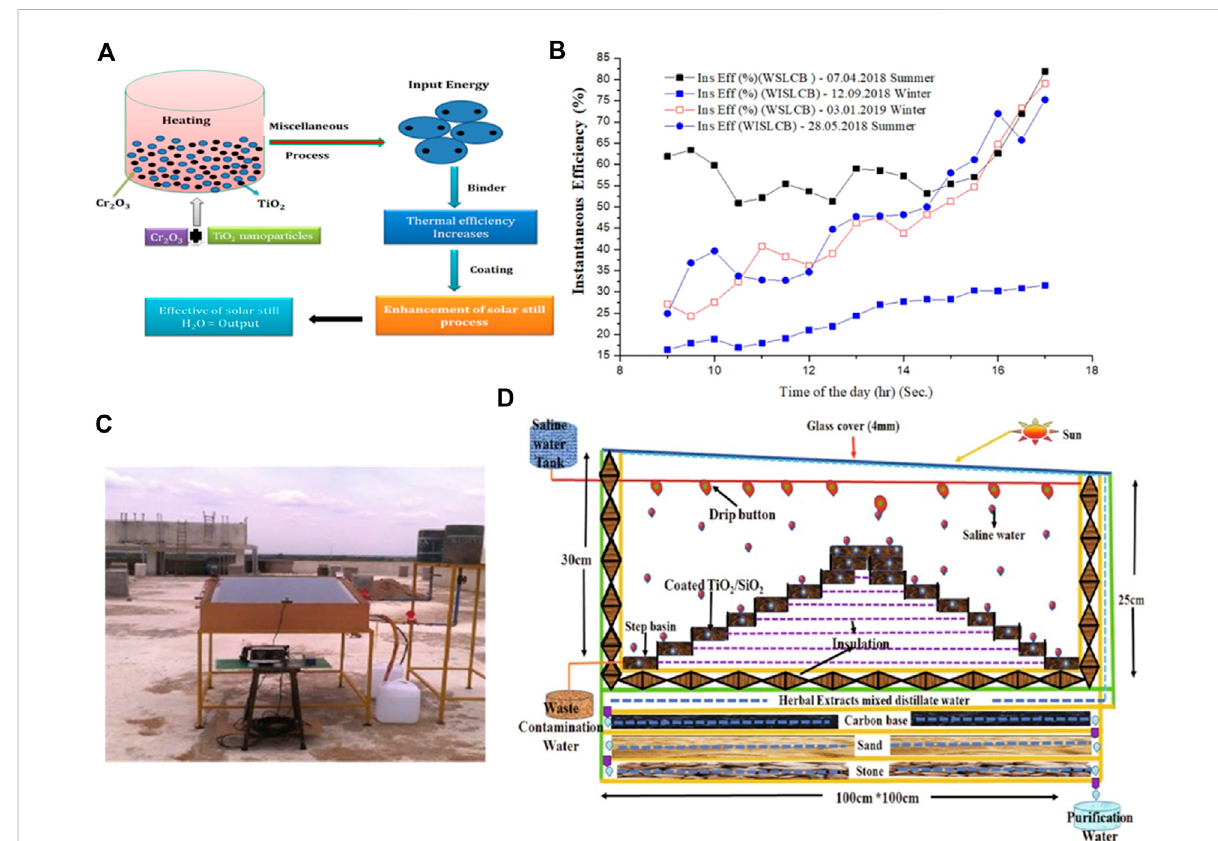
FIGURE 10 (A) Schematic preparation of TiO 2 NPs and Cr 2 O 3 composite coating of a solar still. (B) Variation in absorption ef fi ciency during sunshine hours withandwithoutananolayer coating.(WSLCB — with solar liquid coating basin area, WISLCB — without solar liquid coating basin area) (Shanmugan etal.,2020);Reproducedwithpermission.Copyright2020Elsevier.SiO 2 /TiO 2 nanolayer-coatedsteepedbasinsolarstill(SBSS). (C) Experimental setup view of an SBSS. (D) Schematic diagram of SBSS (Gandhi et al., 2022); Reproduced with permission. Copyright 2022